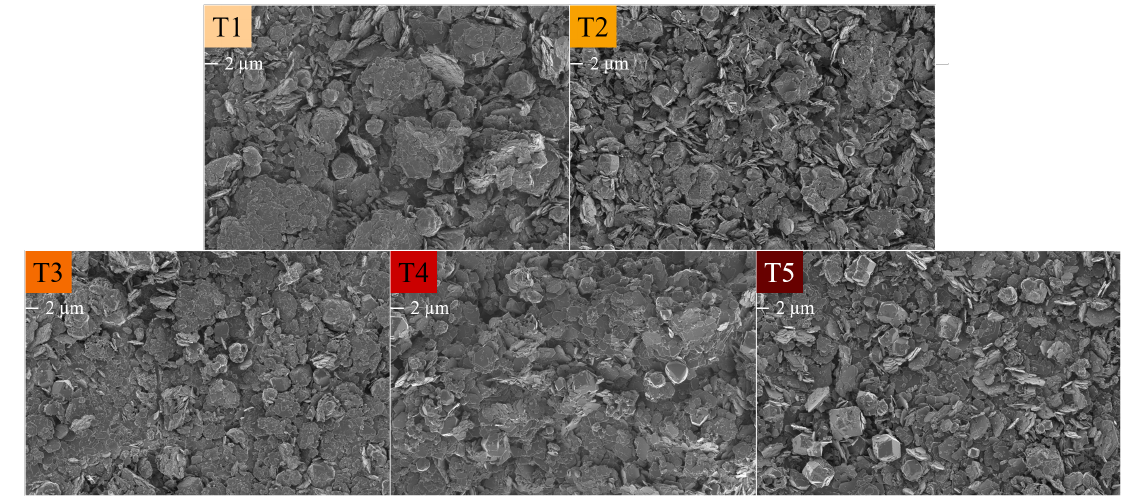
Figure 6. SEM micrographs of the HC LDHs T1 = 20 ◦ C, T2 = 40 ◦ C, T3 = 60 ◦ C, T4 = 80 ◦ C and T5 = 90 ◦ C at 1keV and 2k magnification. The scale bar is indicated under the